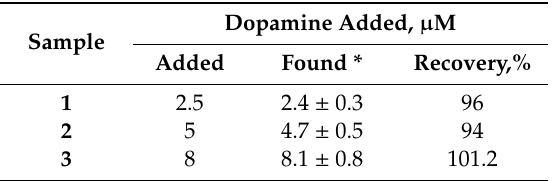
Table 1. Determination of dopamine in spiked human serum